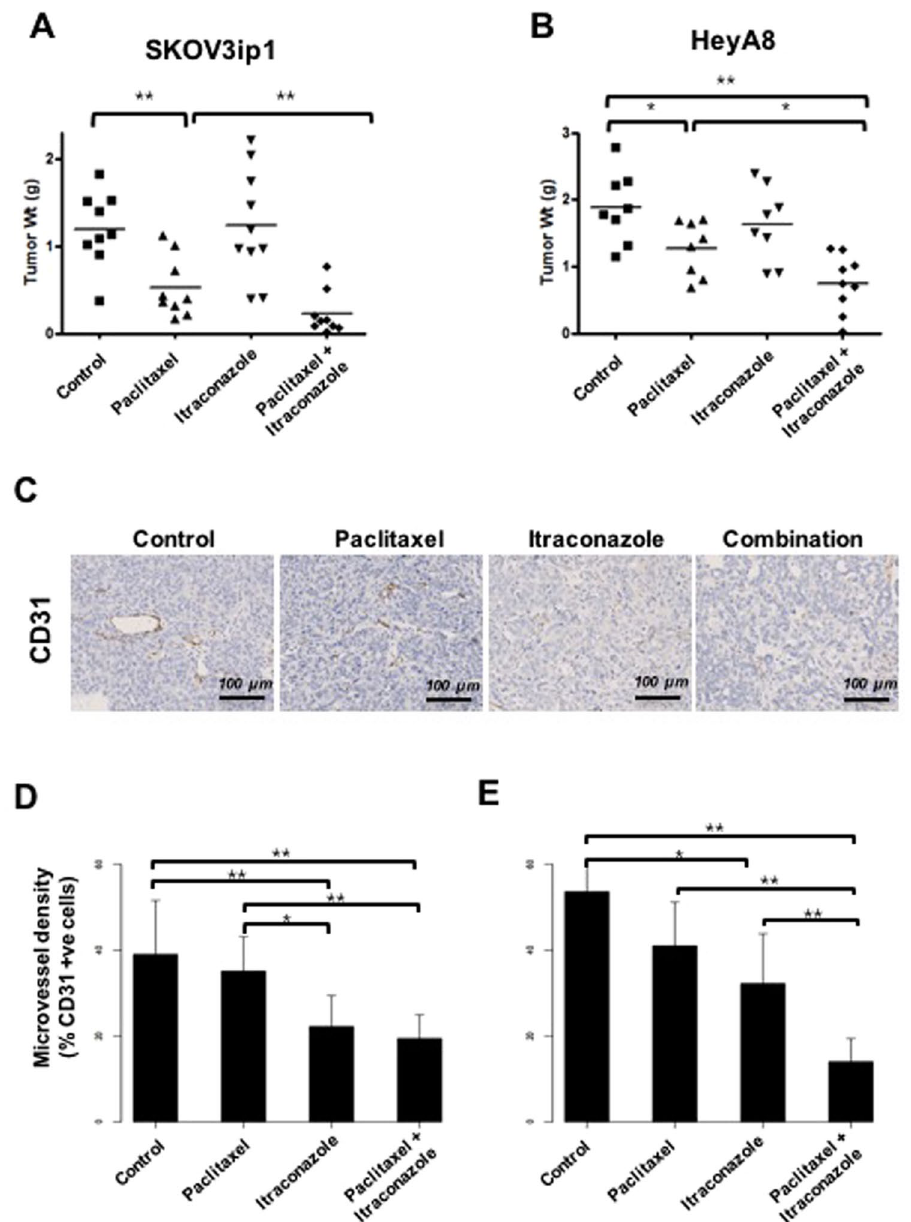
Figure 4. Itraconazole inhibits growth of ovarian cancer xenografts and these xenografts have decreased microvessel density. Mice bearing ovarian cancer cells were treated with vehicle ( n = 10), oral itraconazole 20 mg/kg twice daily ( n = 10), paclitaxel 6 mg/kg intraperitoneally every 7 days ( n = 10), or a combination of itraconazole and paclitaxel ( n = 10). Mice treated with paclitaxel in combination with itraconazole had significantly lower tumor weight than mice treated with paclitaxel alone ( A and B ). CD31-positive tumor vascular area was measured in tumors treated with vehicle ( n = 5), itraconazole ( n = 5), paclitaxel (n = 5), or a combination of itraconazole and paclitaxel ( n = 5) in SKOV3ip ( C and D ) and HeyA8 ( E ) xenograft models. Tumors from mice that received itraconazole monotherapy had a reduced tumor vascular area compared with vehicle-treated tumors ( P = 0.004 for SKOV3ip1 and P = 0.016 for HeyA8, respectively). Addition of itraconazole to paclitaxel reduced tumor vasculature from 35% to 19% for SKOV3ip1 ( P = 0.004) and from 41% to 14% for HeyA8 ( P <